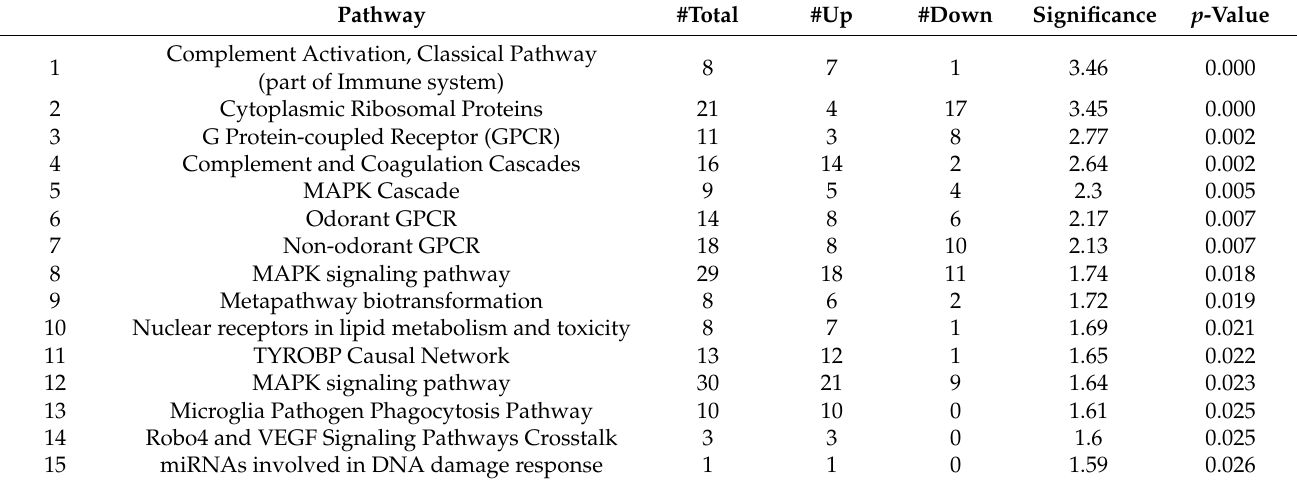
Table 1. Canonical pathways enriched for induced the down-regulated and up-regulated genes of liver from male C57BL/6J mice fed HF+CP.